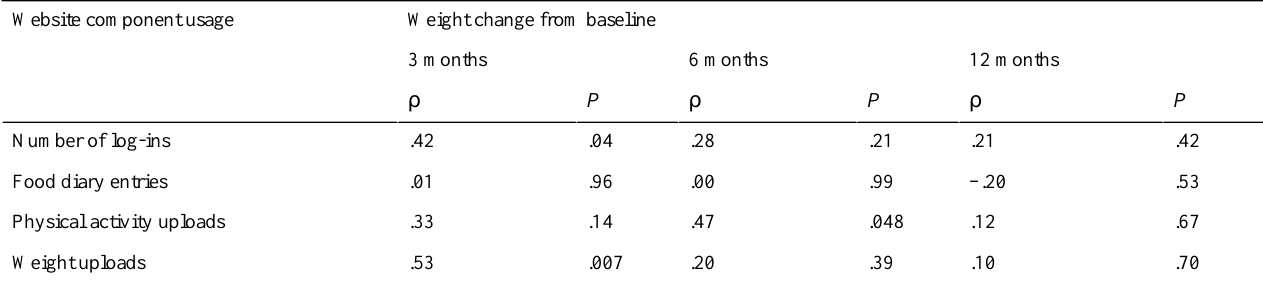
Table 6. Spearman’s correlations ( ρ ) between weight change and website components usage from baseline (intervention group only). Weight change from baselineWebsite component